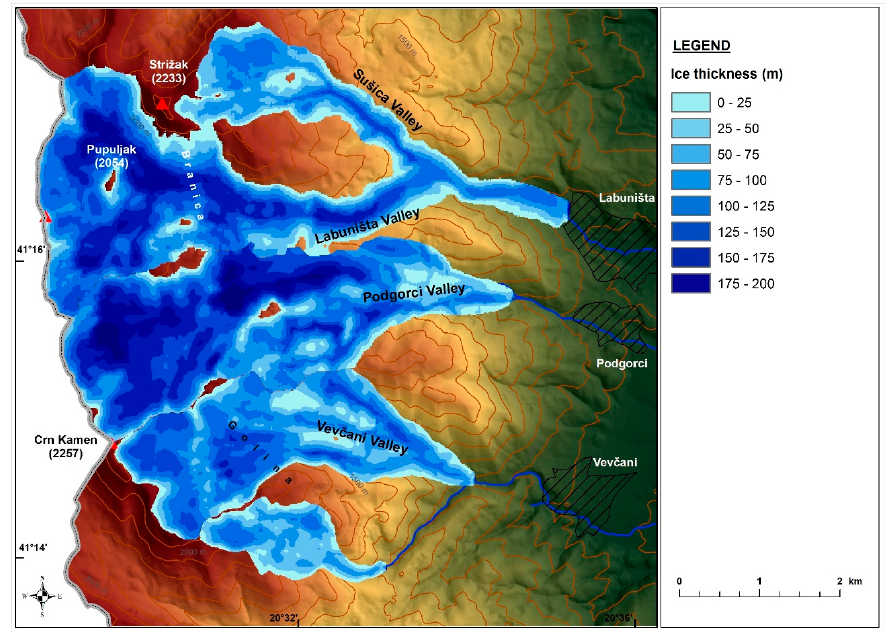
Figure 9. Ice thickness of the reconstructed glaciers during Vev č ani phase in the Jablanica Mt.